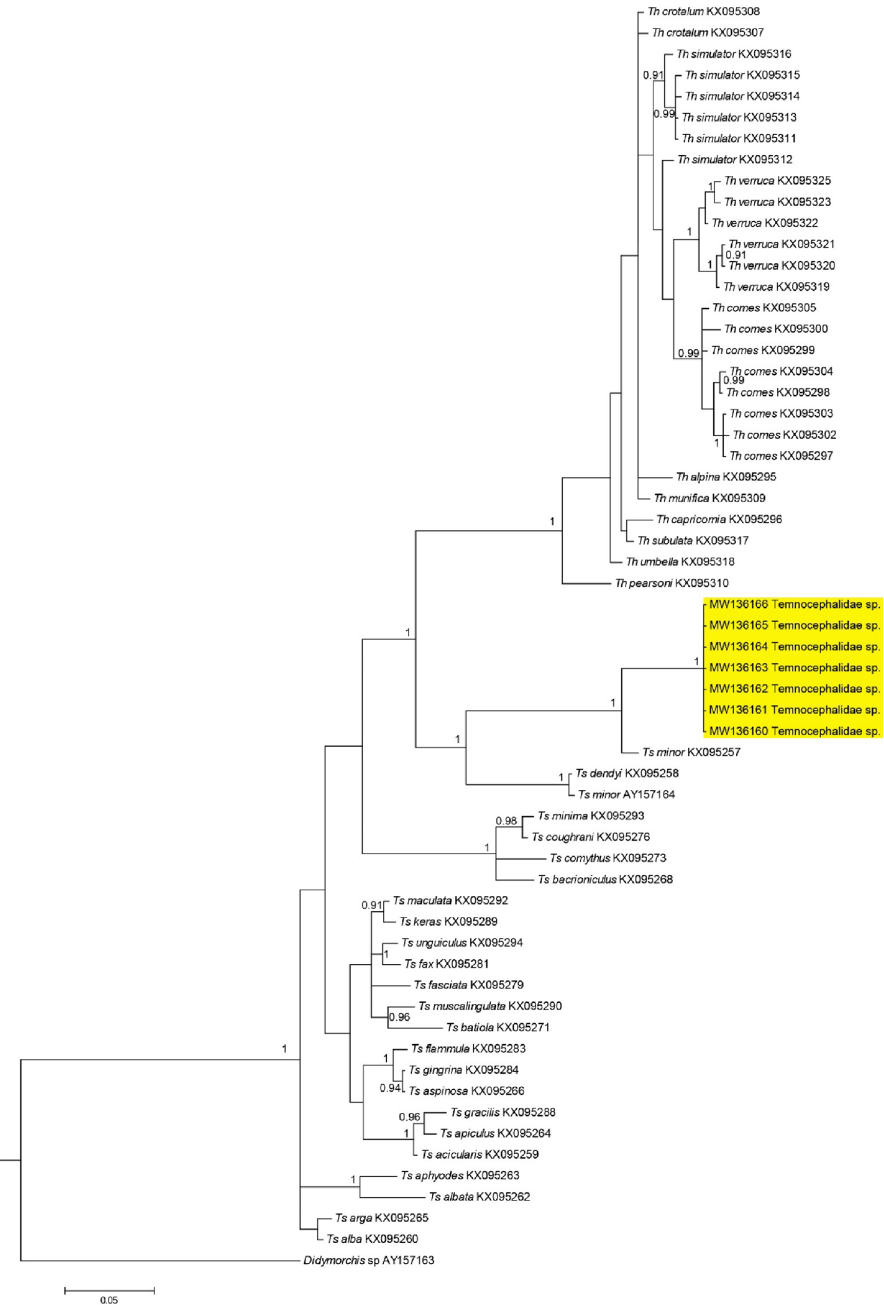
Figure 4. Phylogenetic placement of specimens in the present study based on 28S rRNA sequences, with all available 28S sequences of Temnocephalidae spp. from GenBank. Didymorchis sp. was used as an outgroup in this analysis. Bayesian posterior probability values are indicated on the